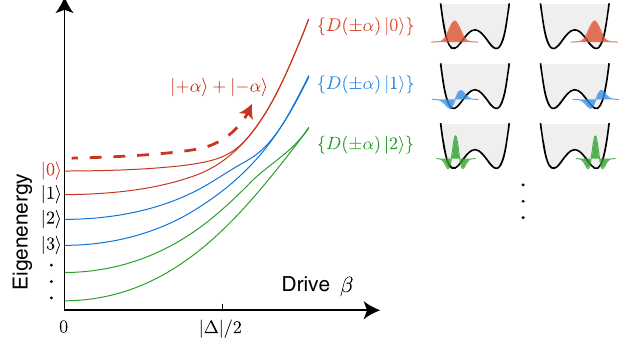
FIG. 8. Eigenenergies of the Kerr parametric oscillator as a function of the driving strength. The plot is made in the classical limit χ ≪ Δ , where the oscillation threshold is at β ¼ j Δ j = 2 . The undriven eigenenergies are decreasing due to our use of a rotating frame at ω p = 2 > ω c . The pairs of neighboring energy levels merge together and become nearly degenerate at large β where the degenerate subspaces are spanned by displaced Fock states. When we adiabatically increase β from 0 to above threshold, the vacuum state will evolve into an even cat state since parametric driving preserves